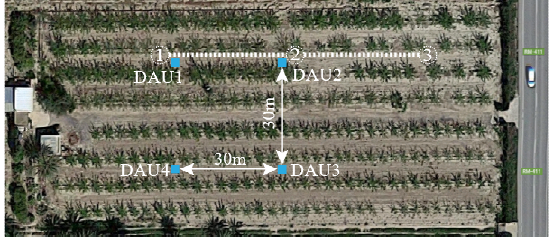
Fig. 2. Real outdoor scenario where experiments were performed.